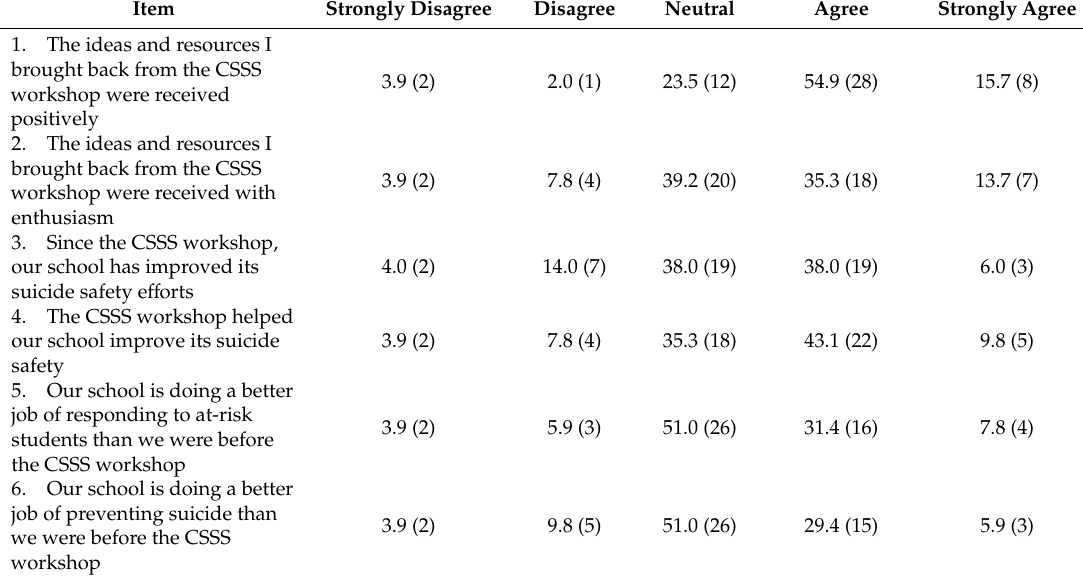
Table 4. Ratings of school-based progress toward suicide safety at 3-month follow-up % ( n ). Item Strongly Disagree Disagree Neutral